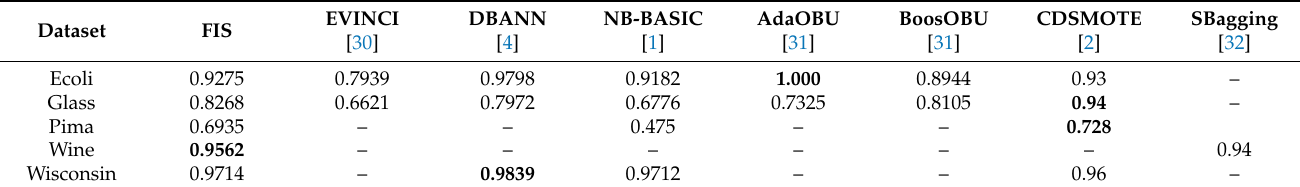
Table 13. Comparative results of G-Mean for the UCI datasets used in the literature. Dataset FIS